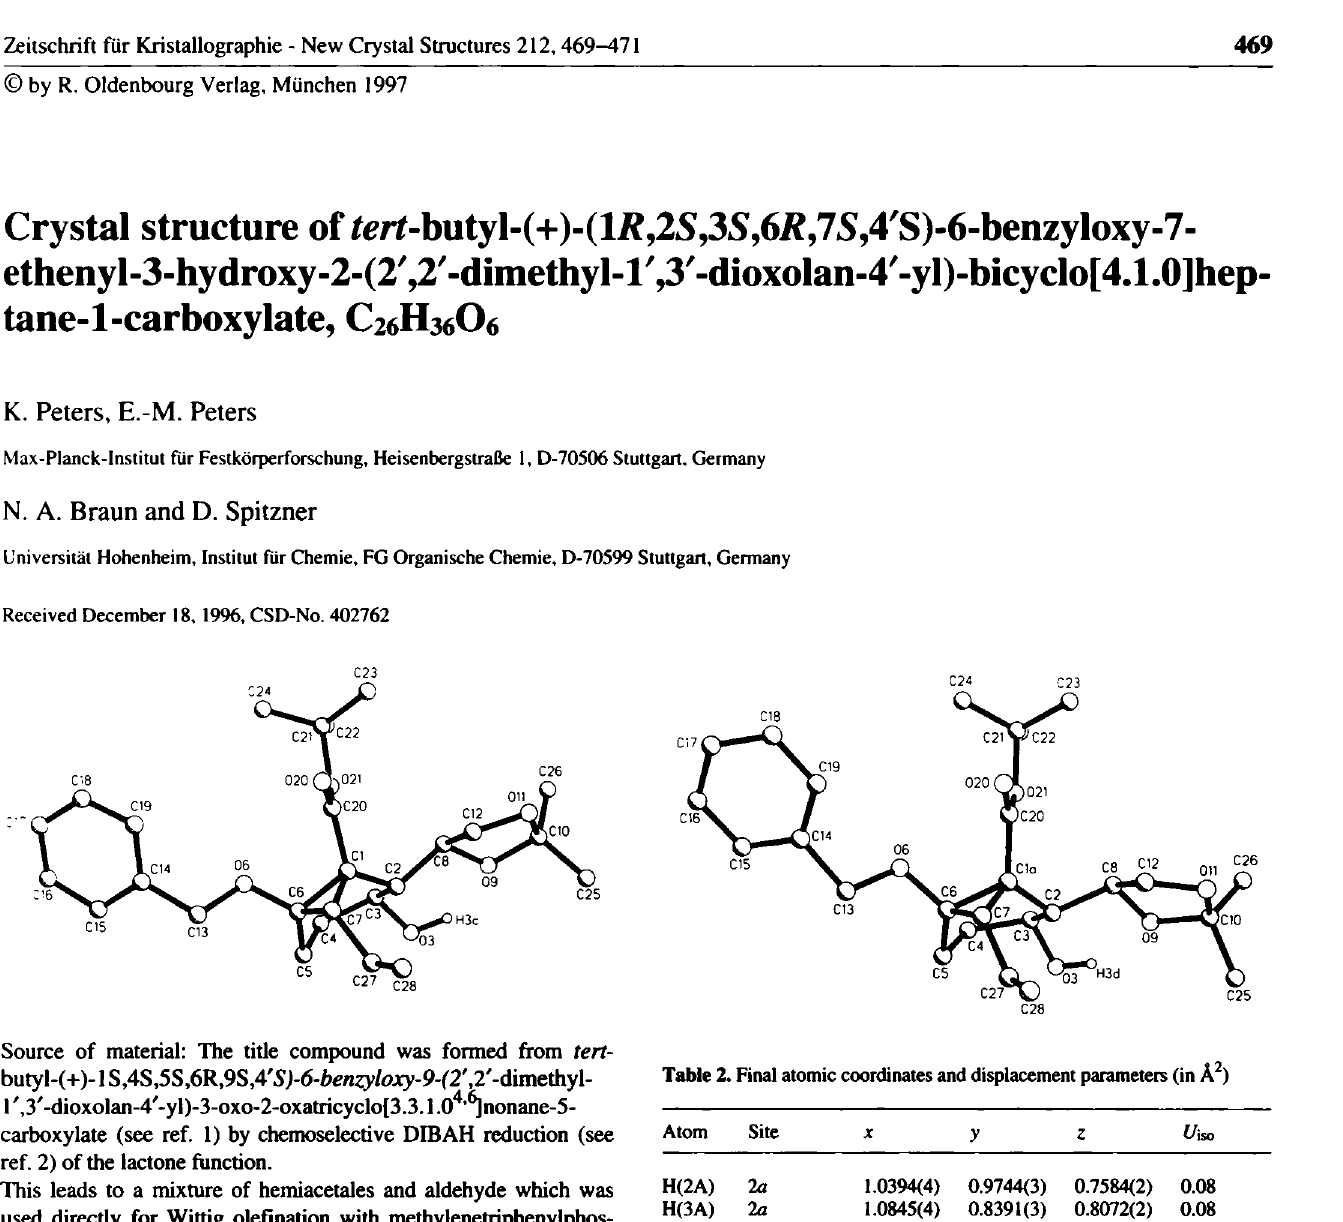
Table I. Parameters used for the X-ray data collection